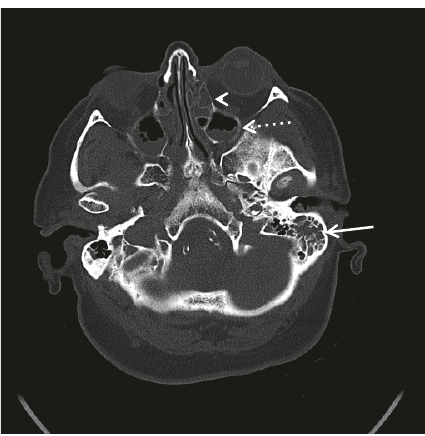
Figure 1: Axial CT demonstrating opacification of the mastoid air cells (solid arrow), ethmoid sinuses (arrowhead), and maxillary sinuses (dashed arrow) in keeping with mastoiditis and sinusitis.